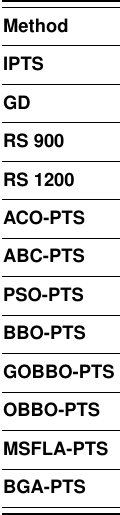
Table 8. Average computational time required for 100 algorithm